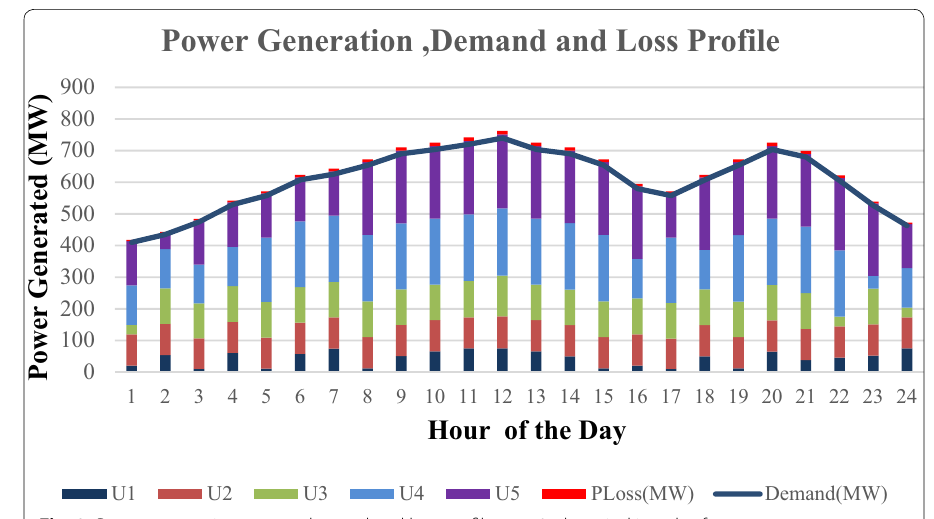
Fig. 2 Power generation, power demand and loss profile over 24-h period in a day for test case 1